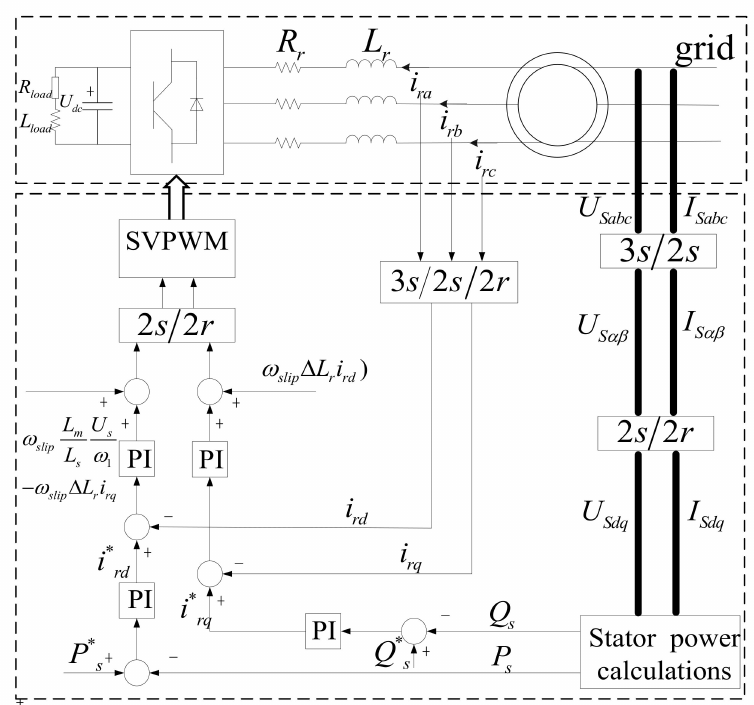
Figure 5. The dq decoupled control of rotor side converter